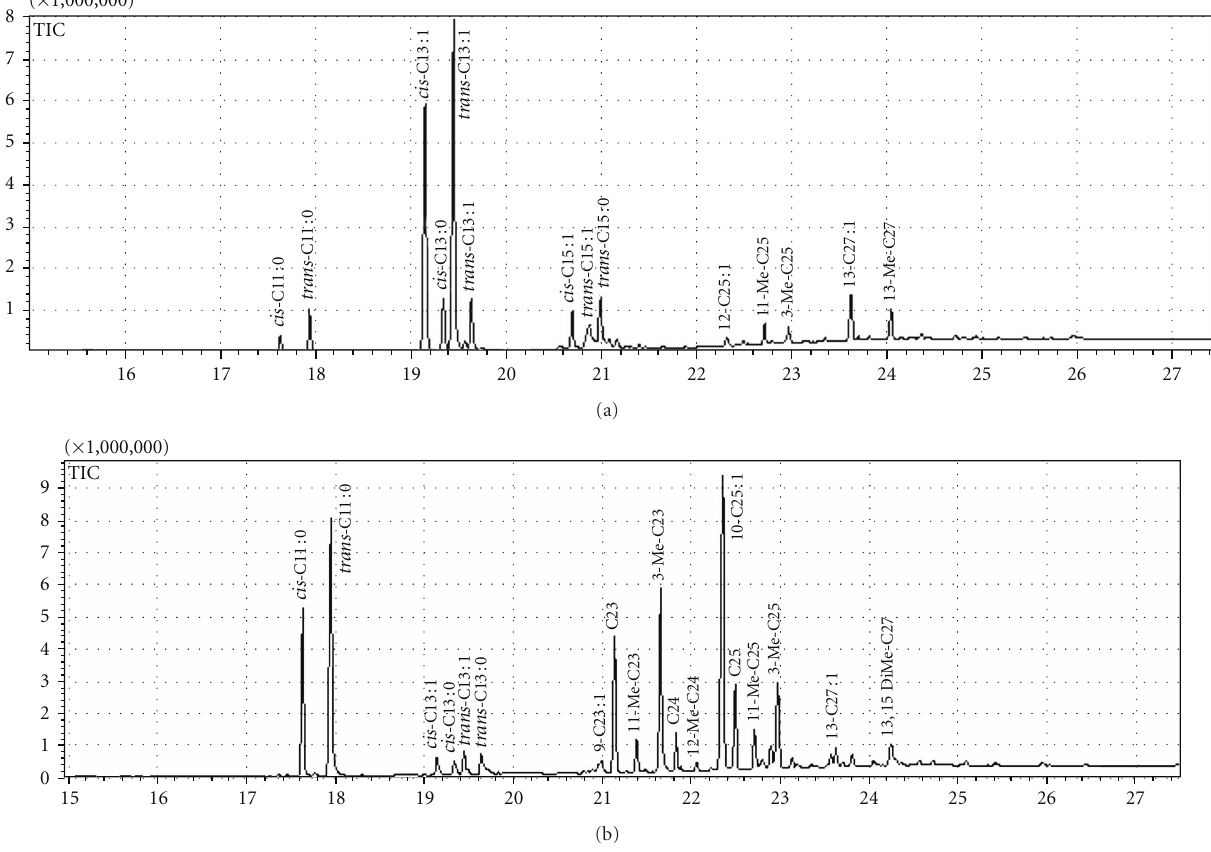
Figure 2: Total ion current chromatograms of (top) field worker sample of Solenopsis saevissima variety A from Bras´ılia, Distrito Federal, Brazil; (below) field worker sample of S. saevissima variety B from Rio de Janeiro, Brazil. For further information on the chemical fingerprints, refer to Table 1 and